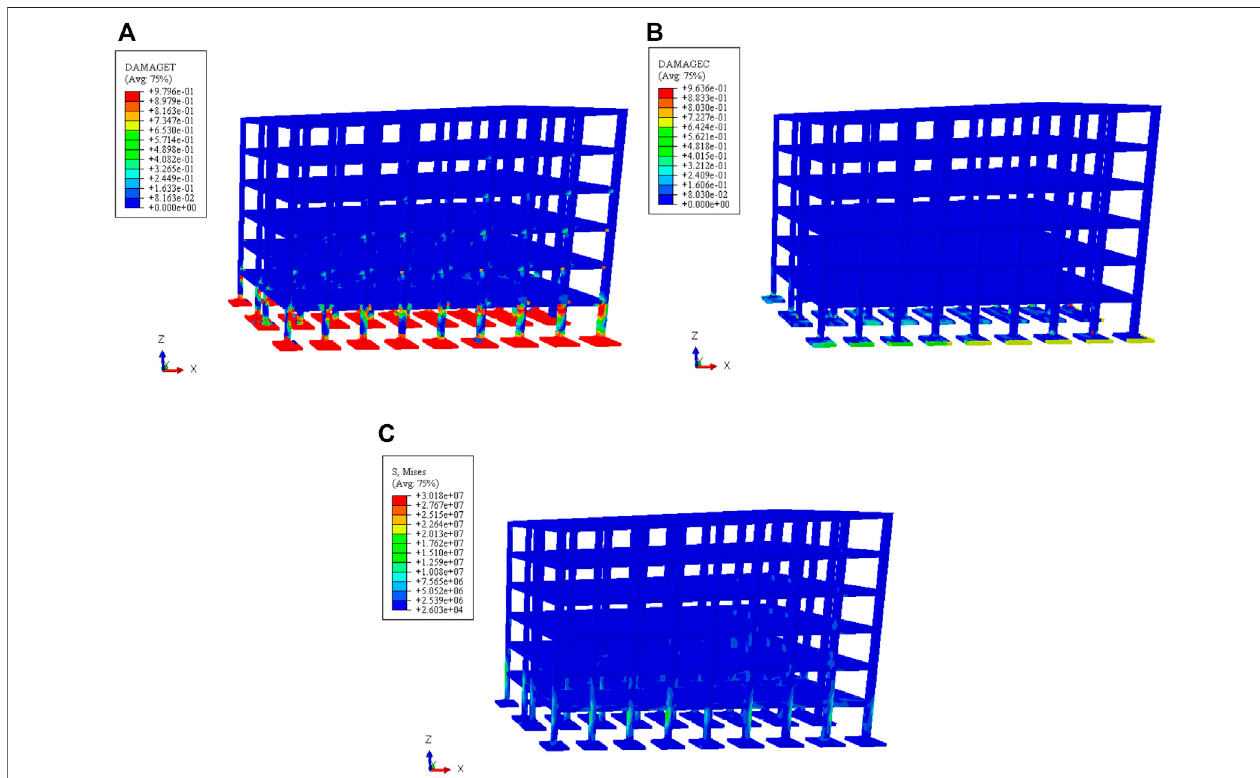
FIGURE 9 | Distribution of deformation and damage of frame structures in each deformation area: (A) buildings damage under the effect of surface deformation in feature-1 area; (B) buildings damage under the effect of surface deformation in feature-2 area; (C) buildings damage under the effect of surface deformation in feature- 3